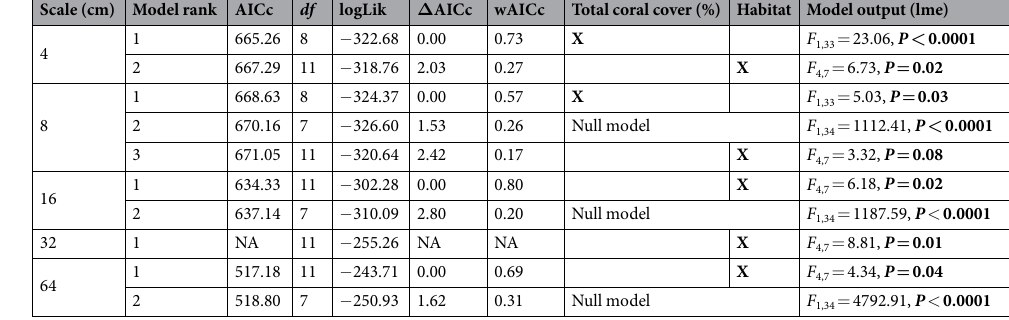
Table 1. Top candidate models selected to describe the relationship between habitat structural complexity across scales (4–64 cm), with total coral cover and habitat type (benthic composition). Models are ranked by Akaike’s information criteria (AICc), with all models within Δ AICc < 3 of the top ranked model. The relative weight of evidence for each model is indicated by Akaike weight (wAICc), and the variables present in each model are indicated with an X. Null models refer to variance explained by site or transect level sampling Outputs are presented for each model, tested using Site as a random effect, and fitted with a constant variance structure to allow for heterogeneity at all scales.